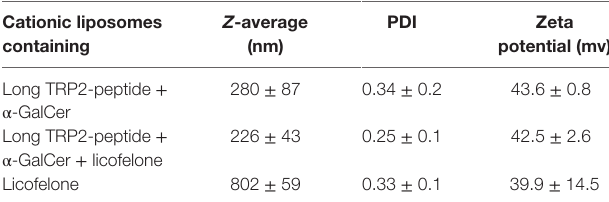
Table 1 | Overview of average particle size, PDi index, and zeta potential of vaccine formulations. cationic liposomes containing